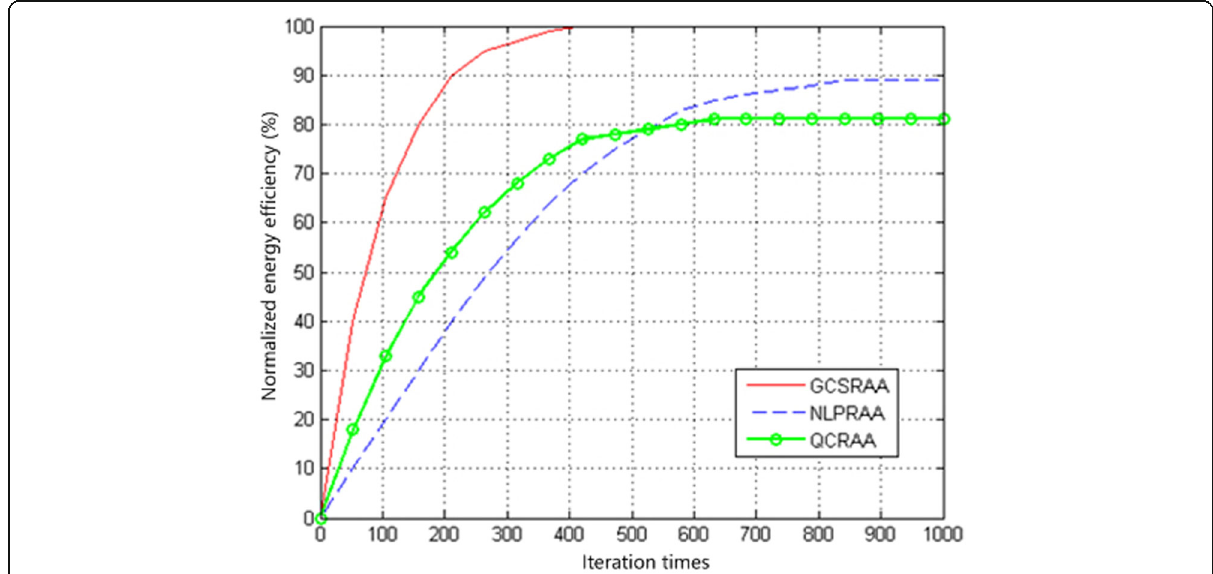
Fig. 6 System energy efficiency v.s. iteration times